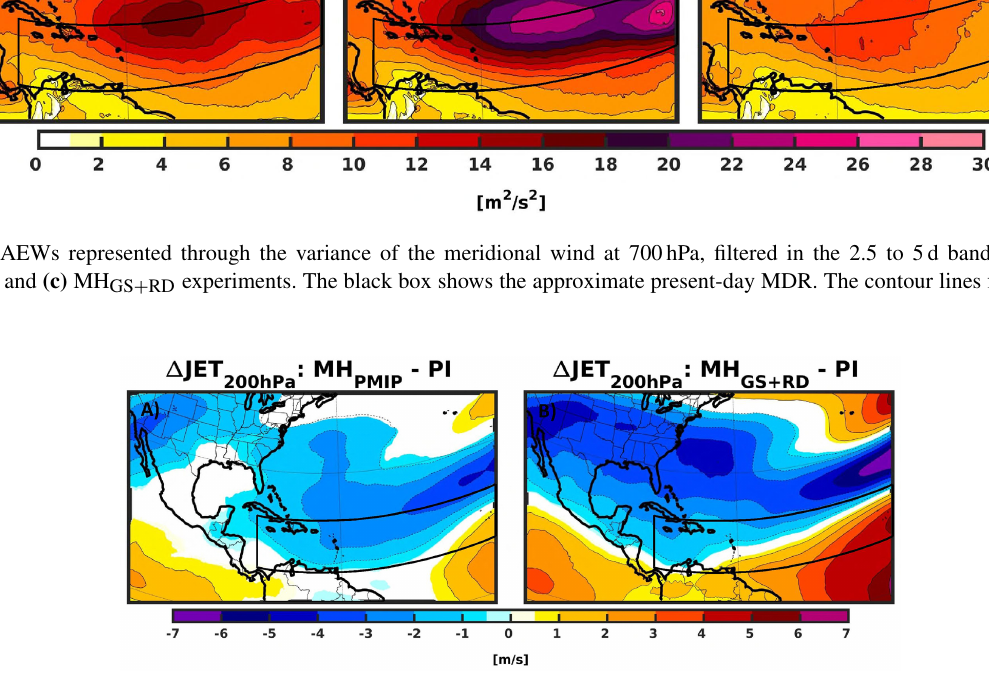
Figure A9. Climatological (JJASON) changes in 200hPa wind speed for the (a) MH PMIP and (b) MH GS + RD experiments relative to PI. The black box shows the approximate present-day MDR. Only values that are significantly different at the 5% level using a local (grid-point) t test are shaded. The contour lines follow the color-bar scale (dashed, negative anomalies; solid, positive anomalies); the 0 line is omitted for clarity.